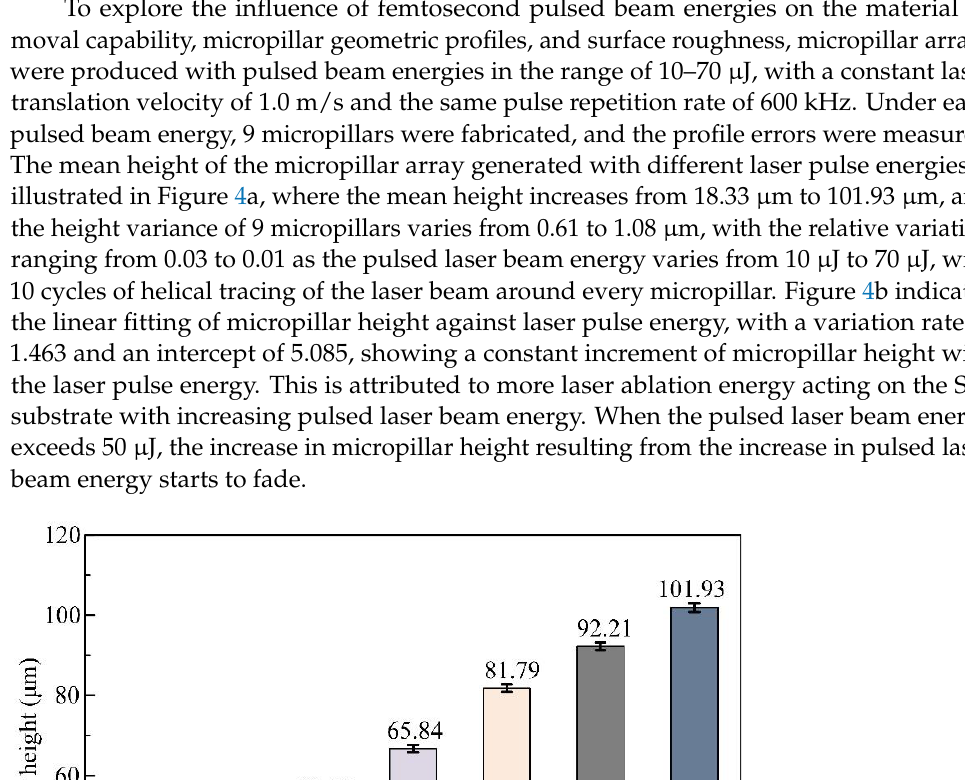
( b ) Figure 4. Effect of pulsed beam energies on the mean height of micropillars with a translation ve- locity of 1.0 m/s and a pulsed repetition rate of 600 kHz. ( a ) Measurements of micropillar height against laser pulse energy. ( b ) Linear fitting of micropillar height against laser pulse energy. Figure 5 shows the variations in both the mean upper and bottom diameters for mi- cropillar arrays under different laser pulse energies. When the pulsed laser beam energy varies from 10 μJ to 70 μJ, the upper diameter shrinks from 281.67 μm to 264.55 μm, and the bottom diameter expands from 311.36 μm to 318.11 μm. The differences in bottom diameters and upper diameters increase with increasing pulsed beam energies. When the pulsed laser beam energy exceeds 50 μJ, the diameter difference between the up per and bot- tom circles reaches a higher value of more than 49 μm.